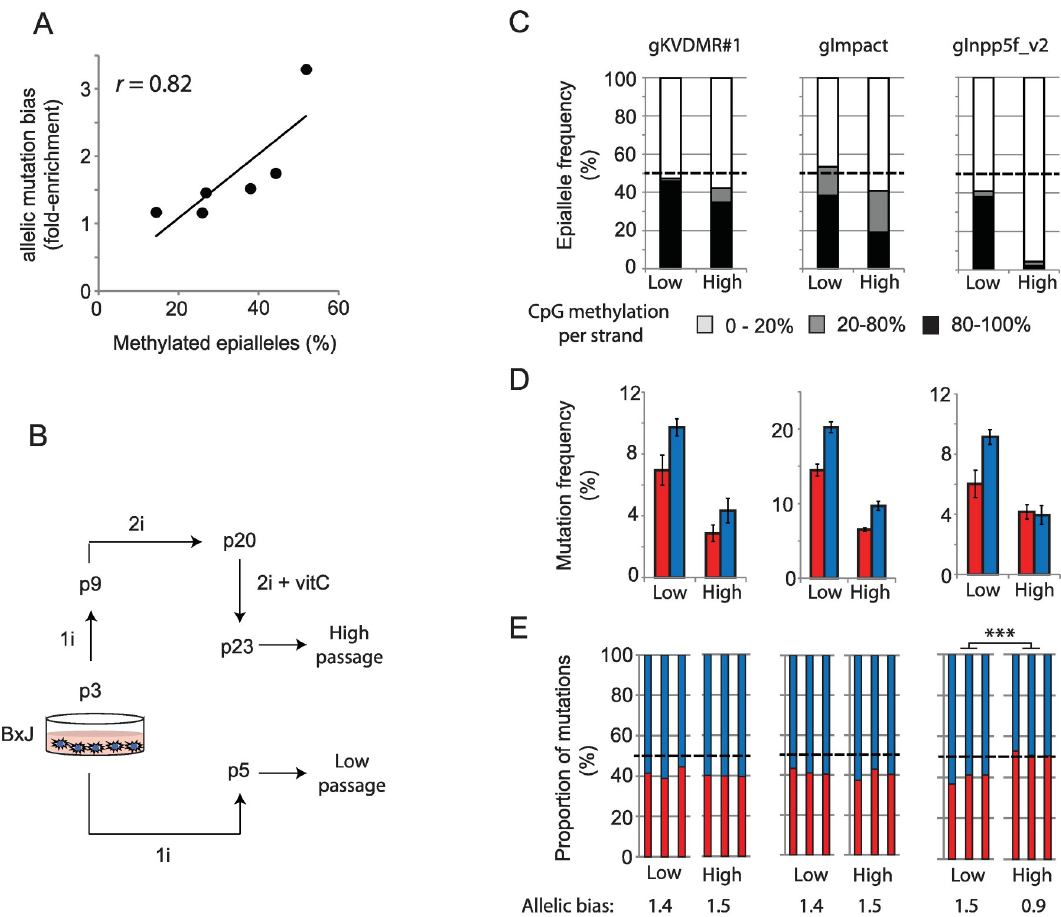
Fig 3. Allele-specific mutation bias is caused by allele-specific chromatin modifications. (A) The degree of methylated alleles correlates with allele-specific mutation bias across three imprinted target sites (sgInpp5f _v2 , sgKvDMR1, sgImpact) in two mESC lines. Each point represents the mean enrichment of mutations on paternal alleles over biological triplicate editing experiments (y- axis) and a single CpG methylation measurement from mock-transfected cells (x-axis). (B) Schematic illustrating the derivation of high-passage cells in order to induce LOI. Media composition (1i, 2i) and cell culture protocols are detailed in Materials and methods. (C) CpG methylation levels at three imprinted loci in low- and high-passage mESCs (B × J only) following mock transfection. Note that only the Inppf5_v2 locus has undergone extensive demethylation during culture. (D) Allele-specific mutation frequencies in low- versus high-passage cells. Error bars represent SD ( n = 3) Transfectants were not selected in these experiments, which accounts for the lower overall mutation frequency relative to Fig 2. Transfection was also less efficient in high-passage cells. (E) Stacked histograms show the allelic mutation bias in each experiment. Asterisks denote p -values for unpaired t tests on the fold-difference between mutation frequencies on maternal and paternal alleles in low- compared to high-passage cells. ��� p < 0.001. Quantitative data underlying panels A, C, D, and E are provided in S1 Data, and details of MiSeq libraries including SRA accessions are provided in S2 Data. LOI, loss of imprinting; mESC, mouse embryonic stem cell; SRA, Sequence Read Archive.